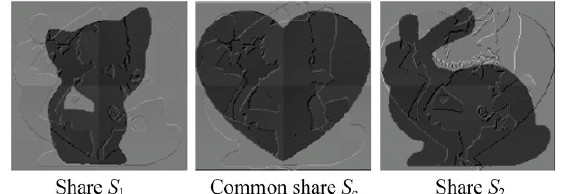
Fig. 9 Information leakage in images after applying optimization to output shares for binary input images (see Fig. 1(right)).